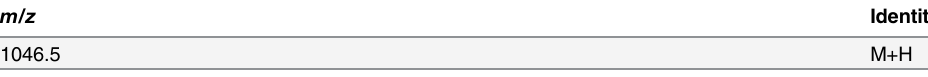
Table 1. Liquid chromatogram-mass spectrum (LC-MS) protonated molecular ion for MC-YR.